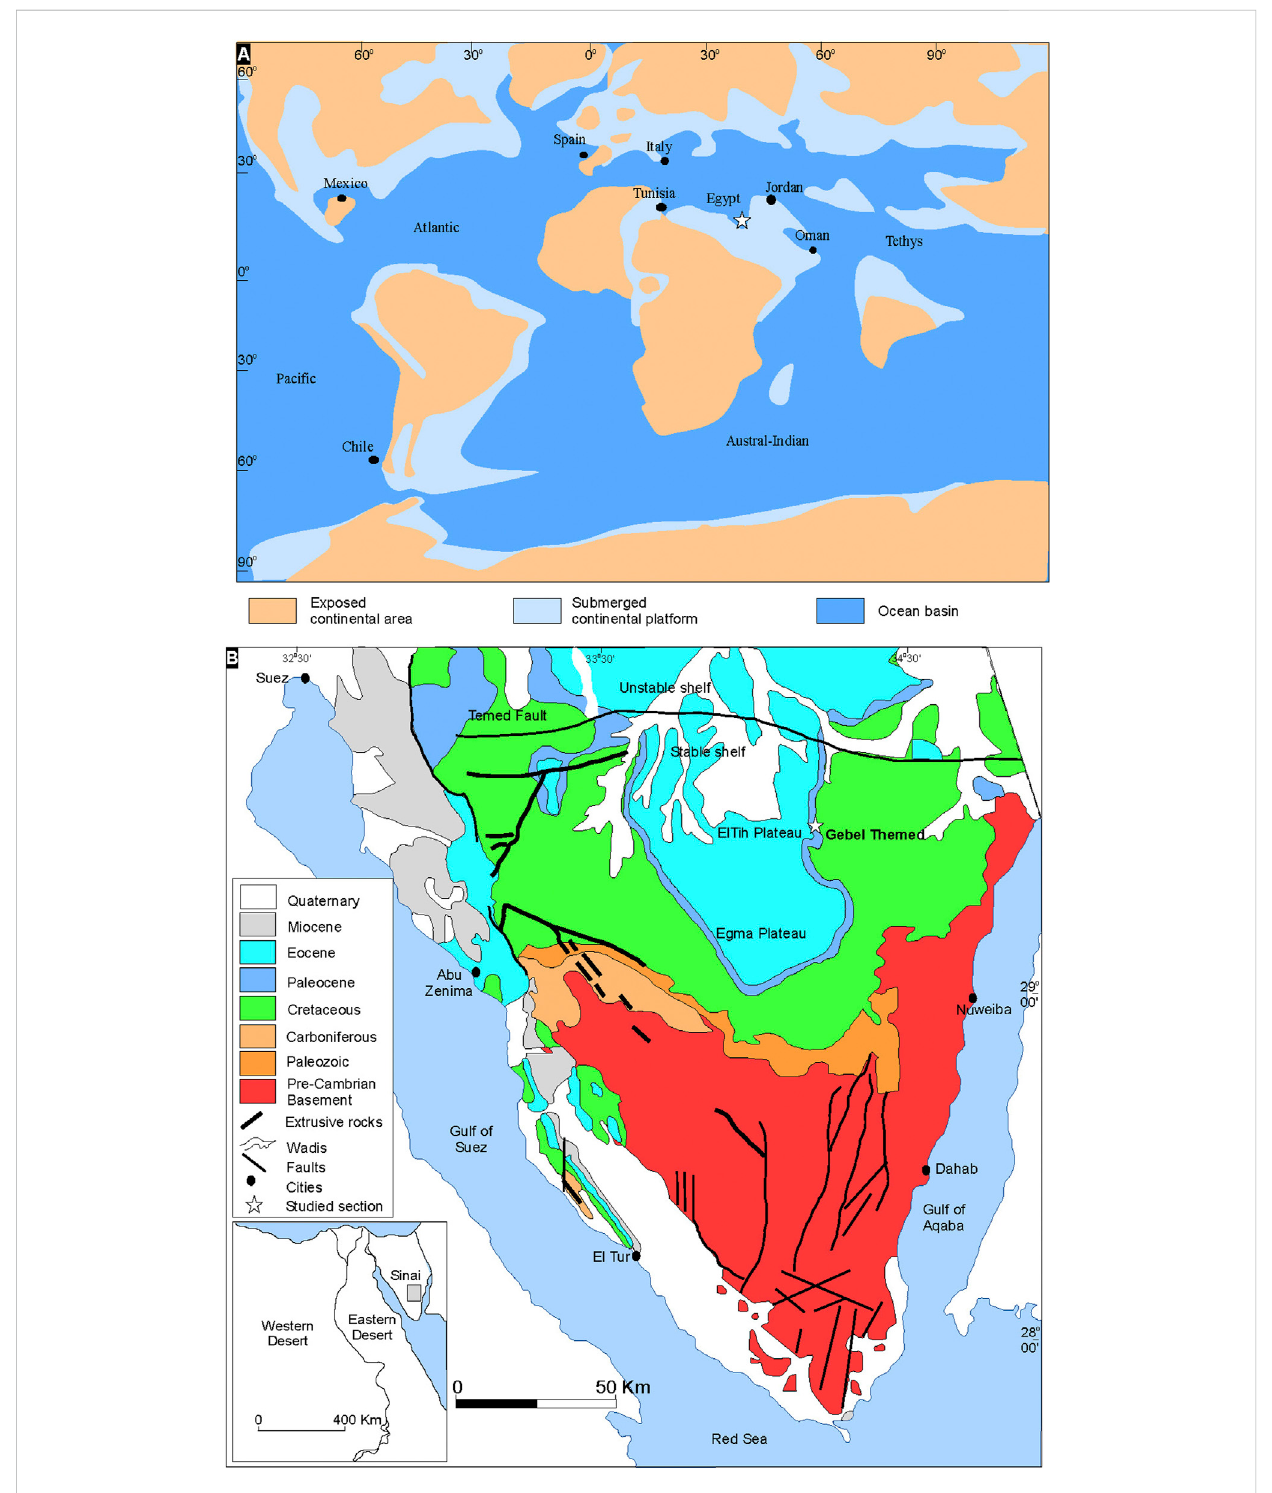
FIGURE 1 (A) Danian paleogeographic position of the study area (modi fi ed after Macleod and Keller, 1991). (B) Simpli fi ed geologic map of Sinai showing the location of the study section (adapted after the Geological Survey of Egypt, 1994).